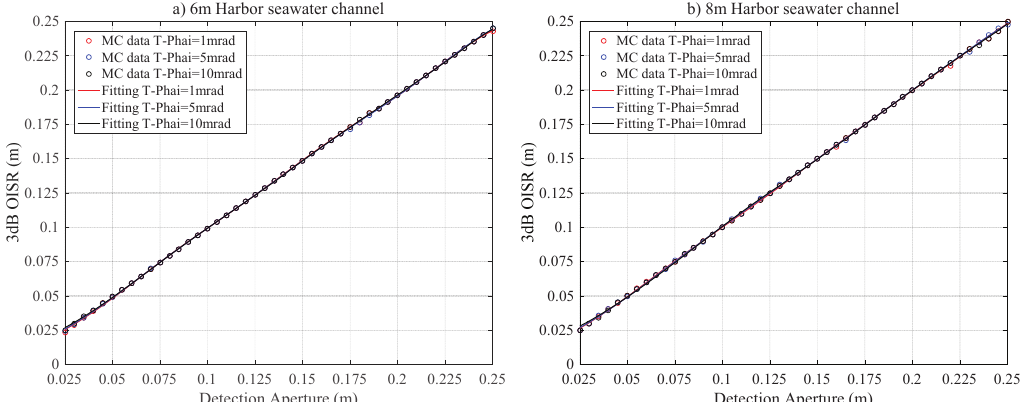
Figure 12. The r 3 dB versus R PD for harbor seawater laser channel for a link distance of ( a ) 6 m and ( b ) 8